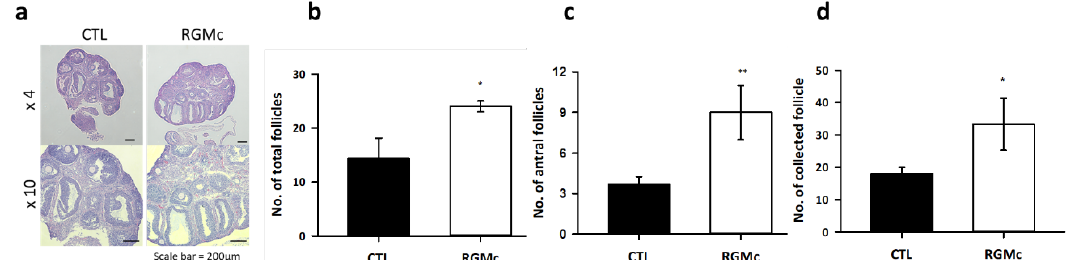
Figure 2. Characterization of RGMc-treated ovaries. ( a ) Light microscopic images of hematoxylin and eosin-stained mouse ovarian tissue treated without (CTL) and with RGMc. Scale bar = 200 µm. ( b – d ) Graphs of the total number of follicles ( b ), number of antral follicles ( c ), and number of collected oocytes ( d ) in control (CTL) and RGMc-treated ovaries. Data are the mean ± SEM of three replicates. * p < 0.05 and ** p < 0.005 versus the control group.